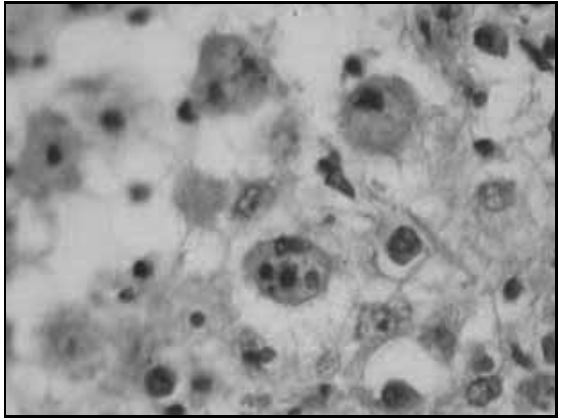
Figura 4 – Hematoxilina e eosina 400×: emperipolese (células inflamatórias íntegras no citoplasma de histiócitos)